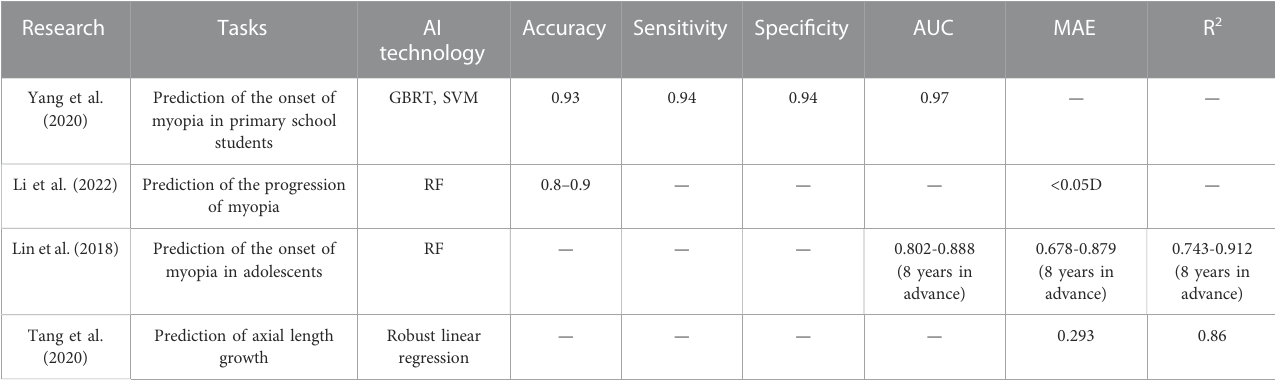
TABLE 1 Summary of CML methods for myopia risk